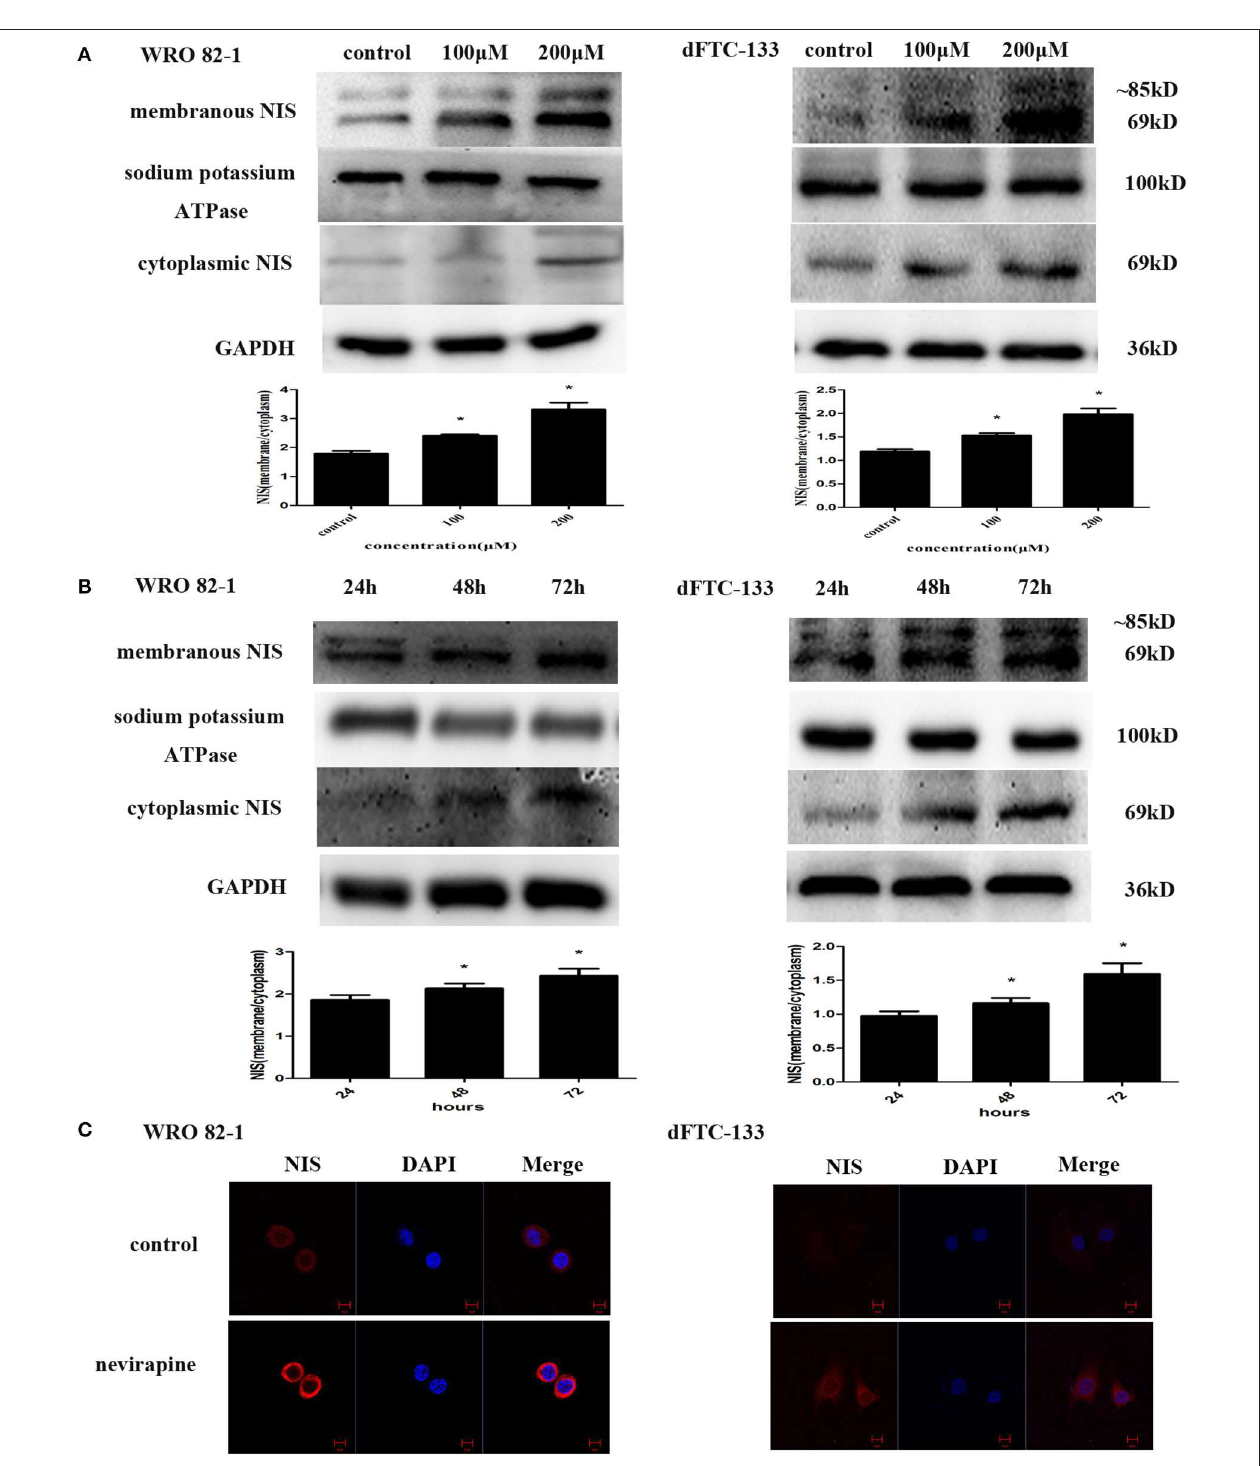
FIGURE 3 | Nevirapine up-regulated cytomembrane-localized NIS protein in WRO 82-1 cells and dFTC-33 cells. (A) Protein expression of membranous and cytoplasmic NIS in WRO 82-1 and dFTC-133 cells treated by nevirapine for 72h was determined by western blot analysis and analyzed quantitatively. Sodium potassium ATPase and GAPDH were used as the loading control. Data are shown as the mean ± SD of three experiments. (B) The expressions of NIS protein in cytomembrane and cytoplasm in both cells with 200 µ M nevirapine in time course experiments were determined by western blot analysis with quantification. (C) Immunofluorescence of NIS protein in WRO 82-1 and dFTC-133 cells by 200 µ M nevirapine for 72h was detected by confocal microscope. Scale bar represents 10 µ m. * P < 0.05 vs. control.